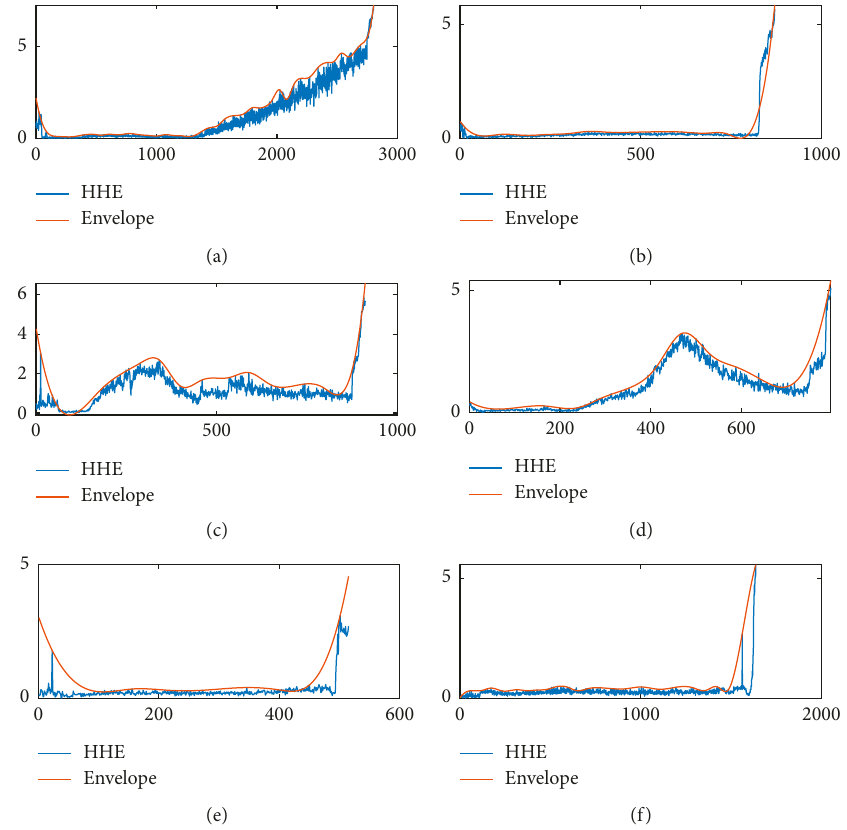
Figure 6: Health indicator. (a) Training set 1. (b) Training set 2. (c) Training set 3. (d) Training set 4. (e) Training set 5. (f) Training set